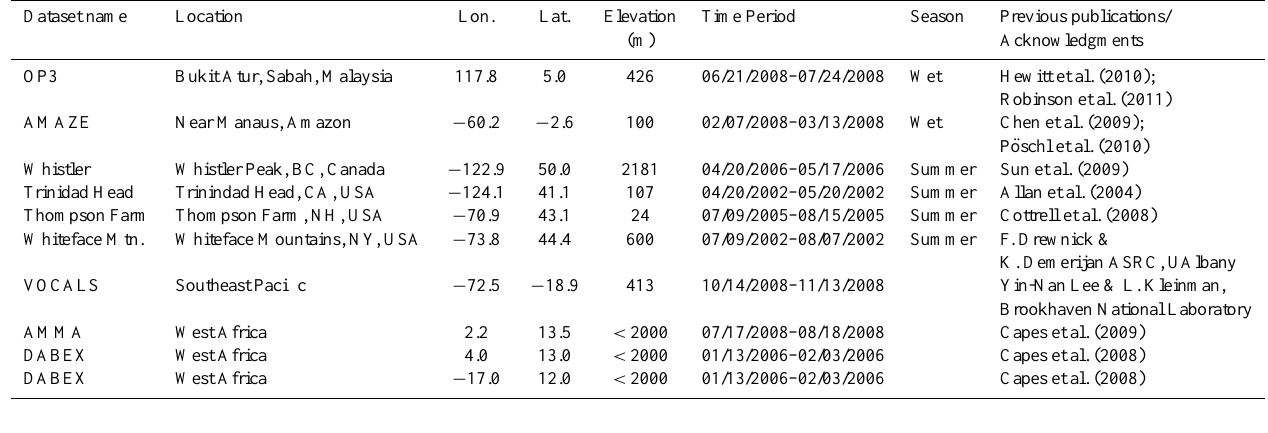
Table 3. Summary of the location, time and duration of the AMS studies, additional to those described in Zhang et al. (2007), that were used in our analysis. All additional sites were classified as remote.